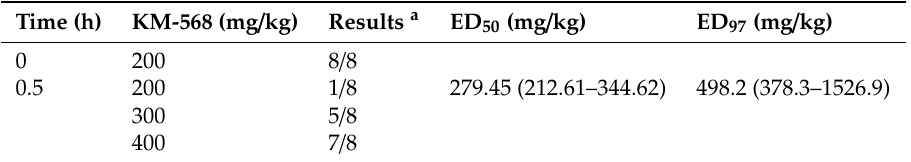
Table 9. Results of pilocarpine-induced status epilepticus model in rats (compound KM-568 was administered i.p .).